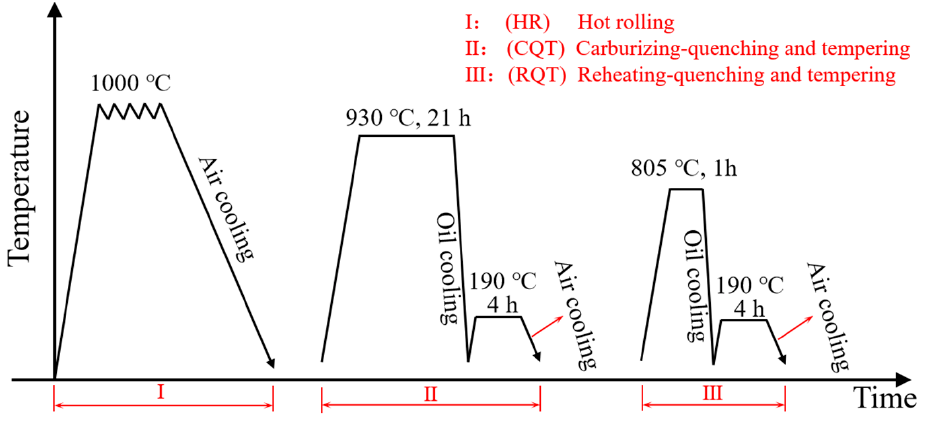
Figure 1. Hot rolling and heat treatment process of experimental steel. Table 2. The conditions and corresponding abbreviations in the forming process. Thickness Reduction Process